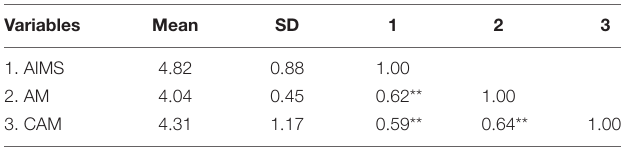
TABLE 5 | Descriptive statistics and Pearson product-moment correlations between the athletic motivation and career athletic motivation (SAMSAQ-KR) and Athletic Identity Measurement Scale (AIMS).